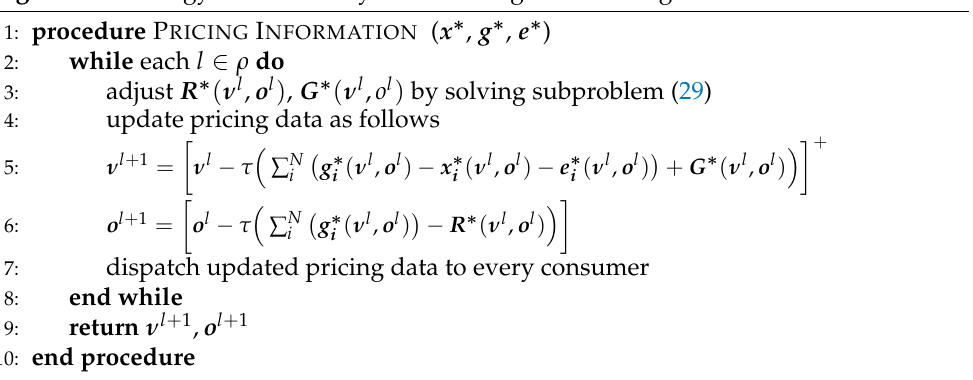
Algorithm 2 Energy Provider’s Dynamic Pricing Decision